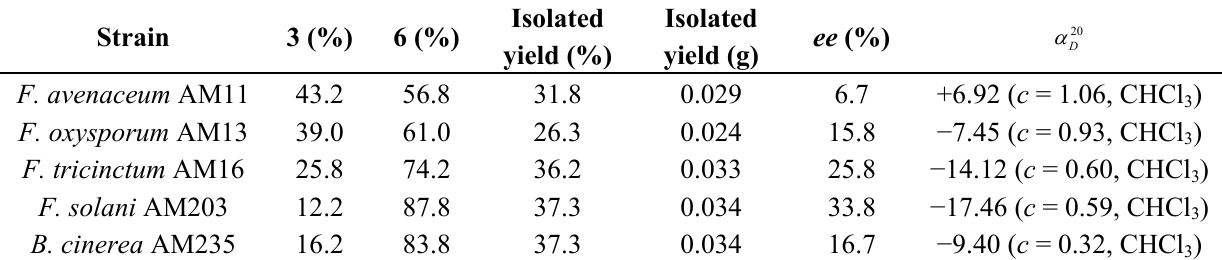
Table 2. Results of preparative biotransformations of lactone 3 after 14 days.